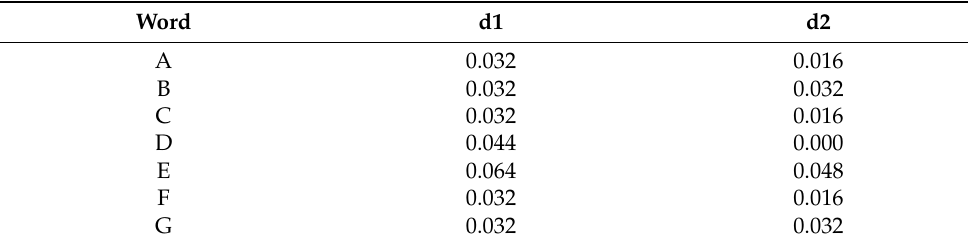
Table 6. Representation probability value of feature